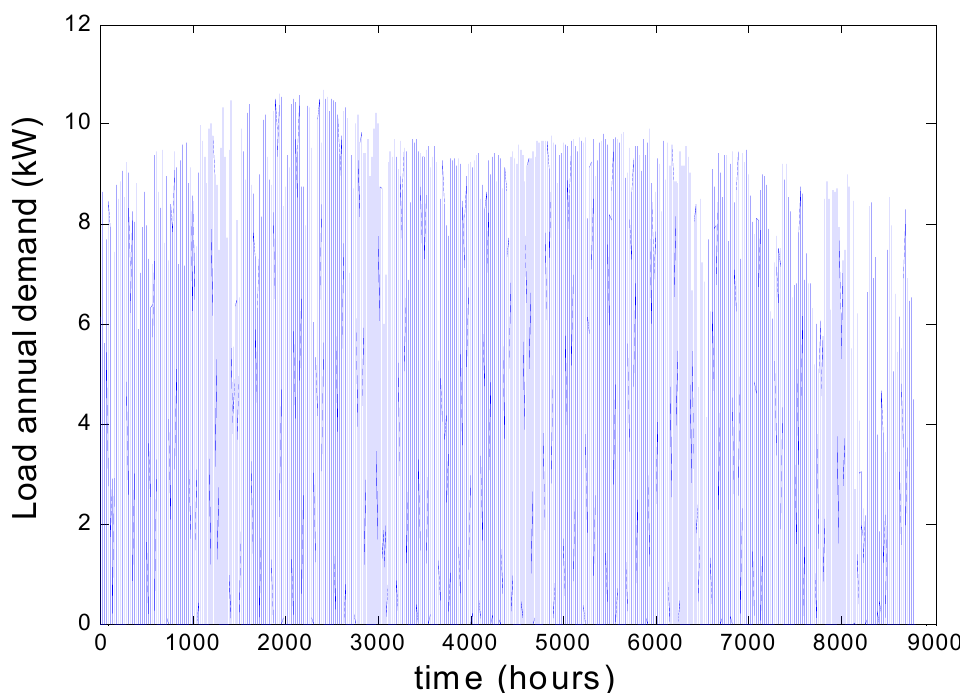
Figure 6. TST annual power.